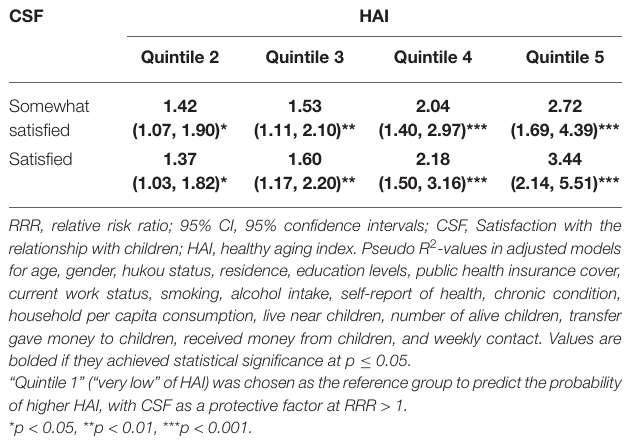
Table 4 . CSF played a partial mediating role between monthly CCT and HAI in women ( z = 2.885; indirect role = 0.025, CI = 0.016–0.033; direct role = 0.371, CI = 0.265–0.477; p < 0.001), and rural ( z = 3.093; indirect role = 0.021, CI =